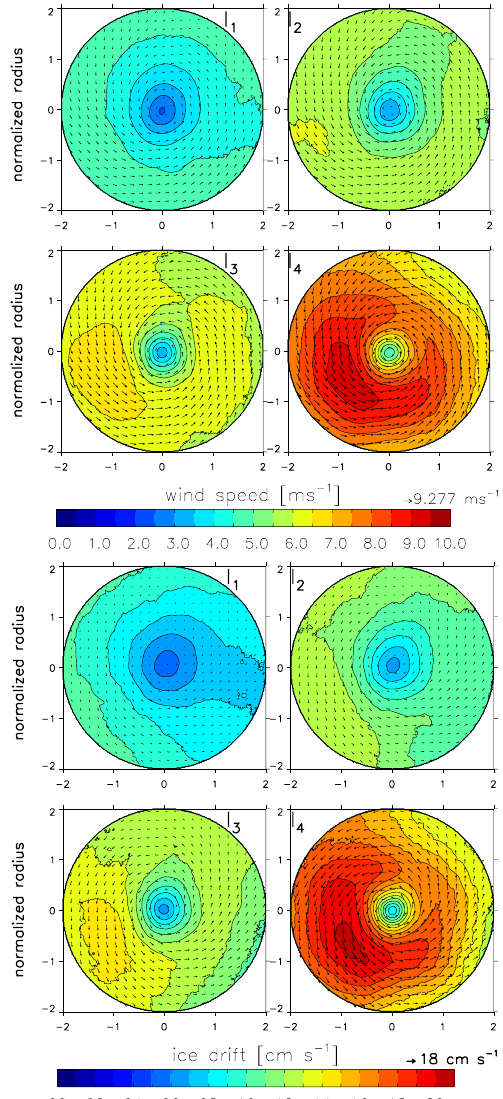
Fig. 3. Mean wind (top) and mean ice drift (bottom) for the intensity classes I 1 to I 4 , centred on the location of the cyclone detection and normalized with the cyclone radius. Mean vectors as arrows, mean over absolute value of the speed as color. Isoline interval is 0.5ms − 1 for wind speed and 1cms − 1 for ice